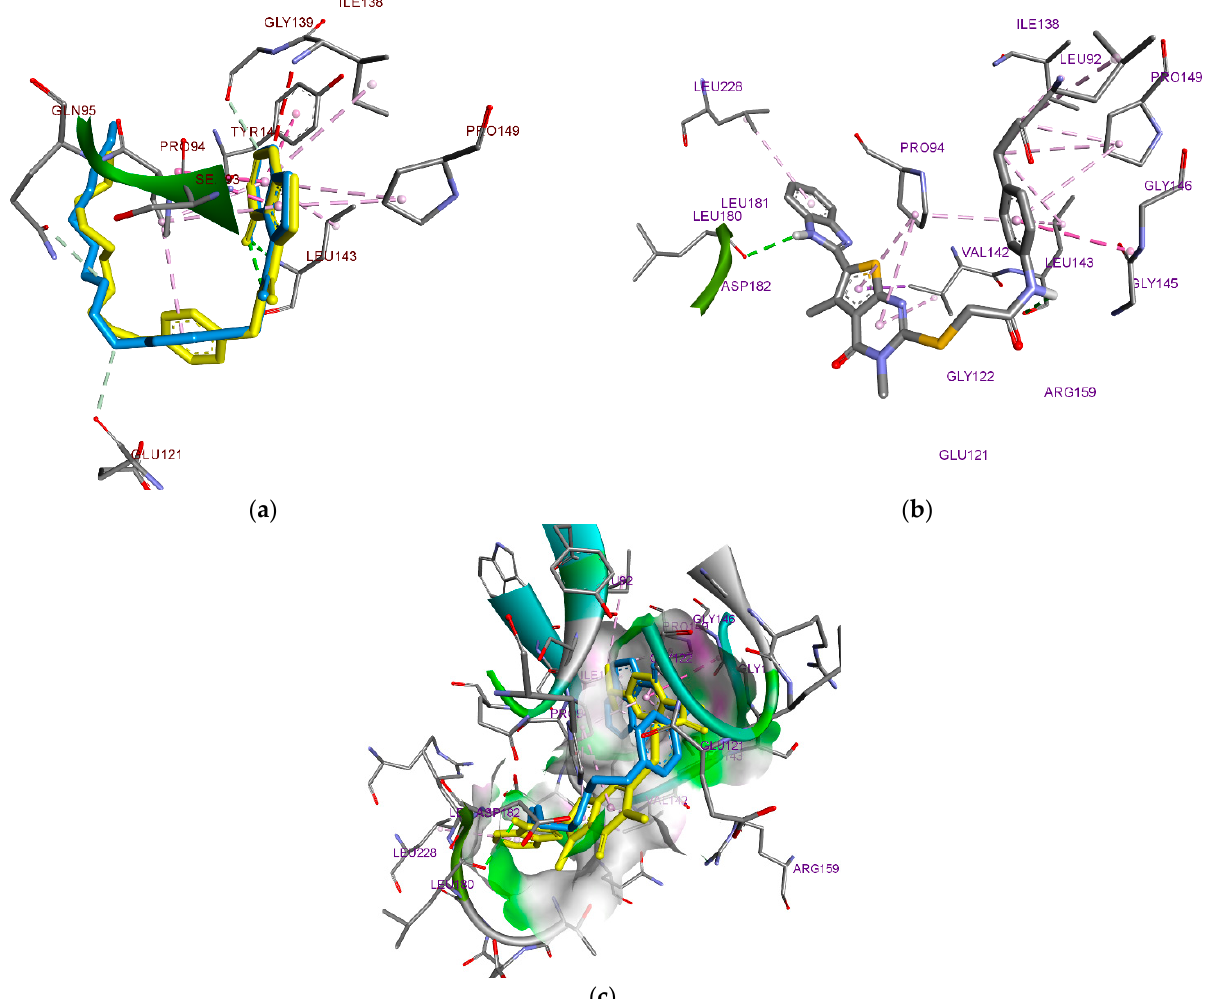
Figure 3. 3D visualization: ( a ) the arrangement of the reference native ligand (blue structure) [23] and the reference ligand (yellow structure) in the active site of TrmD of P. aeruginosa ; ( b ) interaction of 4d with amino acids of the active site of TrmD inhibitors; ( c ) conformations of both the native inhibitor (blue structure) and the ligand 4d . Table 1. The results of the target thieno[2,3- d ]pyrimidines 3, 4a-l, 5 and the reference ligand docking studies to the active site of P. aeruginosa TrmD.